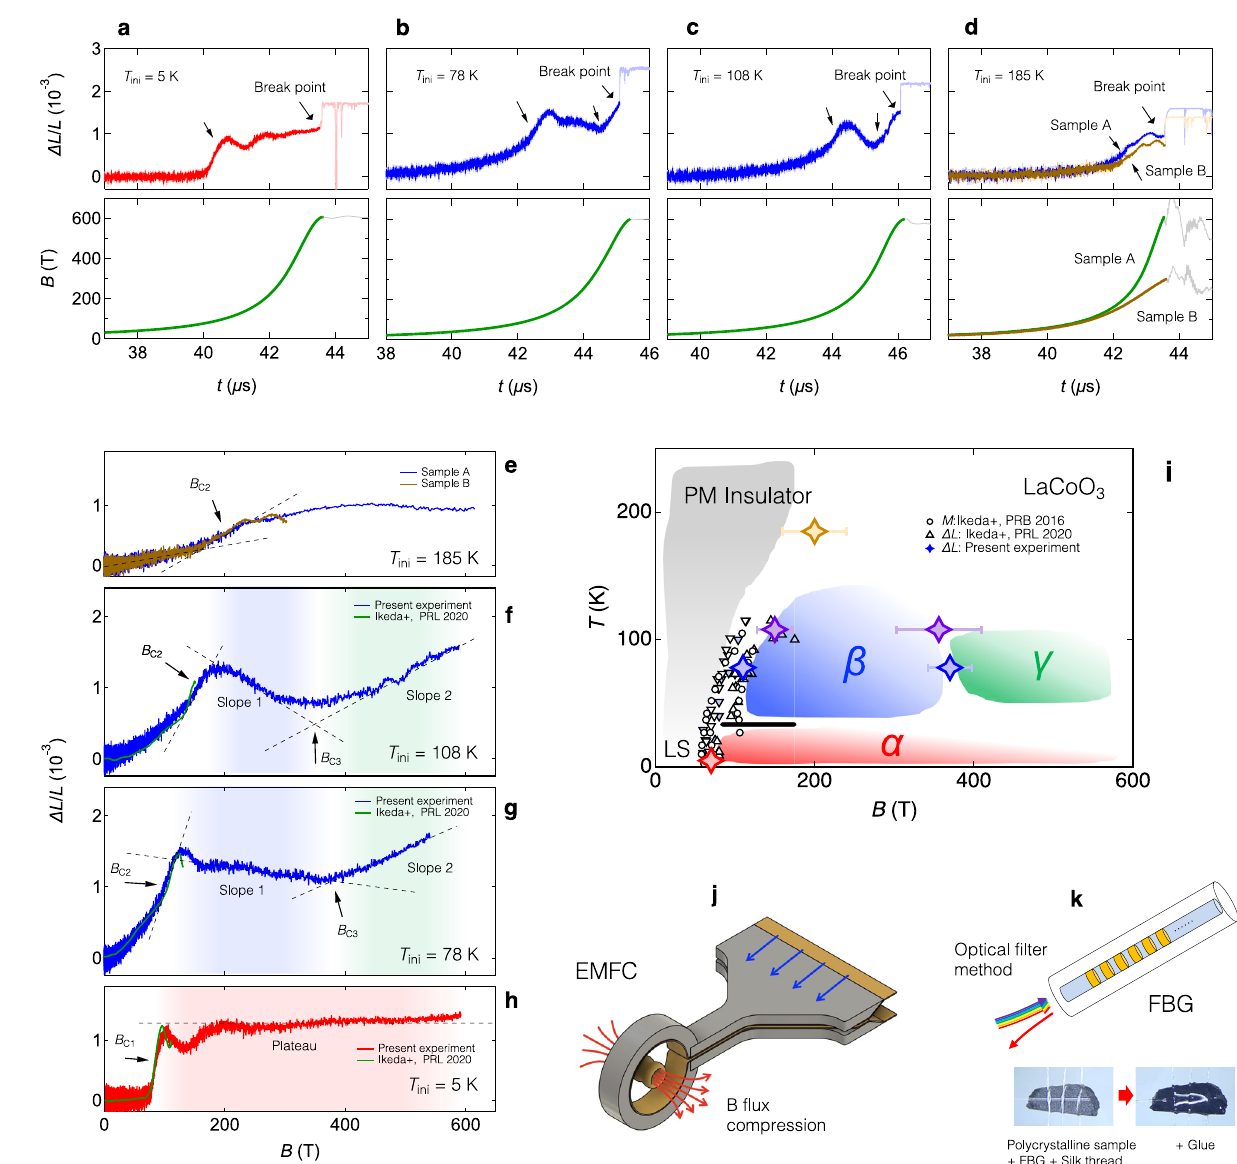
Fig. 3 | Magnetostriction data up to 600T for LaCoO 3 atvarious temperatures and the summarizing phase diagram. a-d Result of magnetostriction measure- ment of LaCoO 3 shownasafunctionof time,along with the magnetic fi eldpro fi les generated using the EMFC method. The initial sample temperatures T ini are varied from 5 K to 185 K. e-h Magnetostriction data of LaCoO 3 shown as a function of magnetic fi eld at various T ini , along with the reference data (Green curves) pre- viously obtained using STC 29 . i Summary of the magnetostriction measurement of